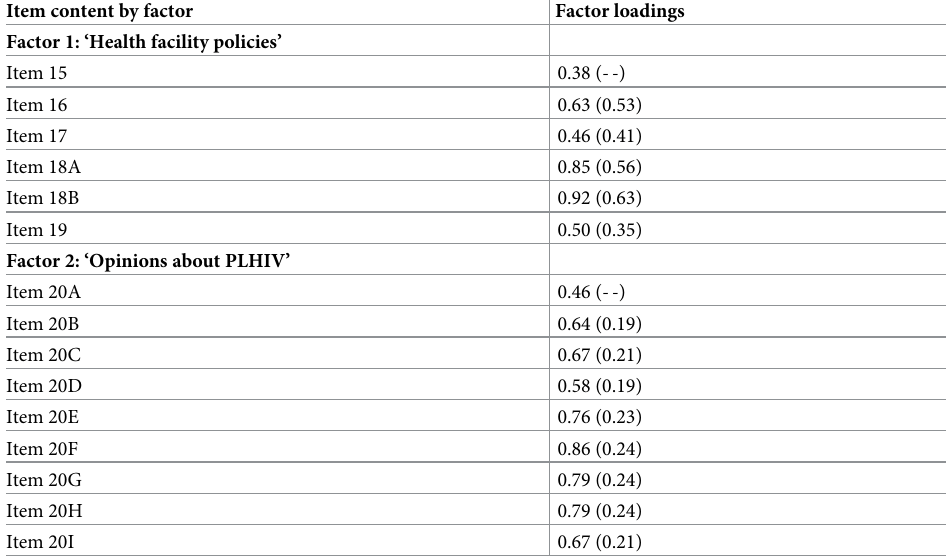
Table 4. Standardized factor loadings with corresponding standard errors of the original and extended HIV- related scales on CFA models (N = 159). Item content by